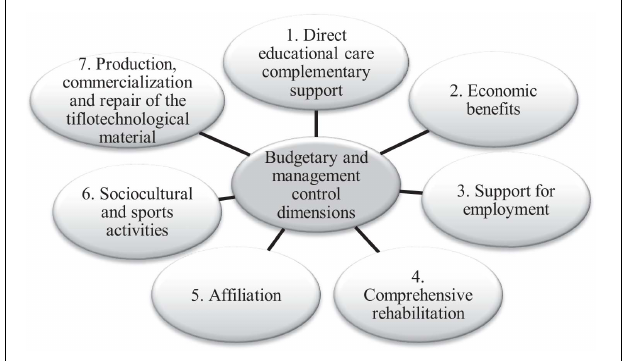
FIGURE 1 | Social management measurement scale design process. Source: